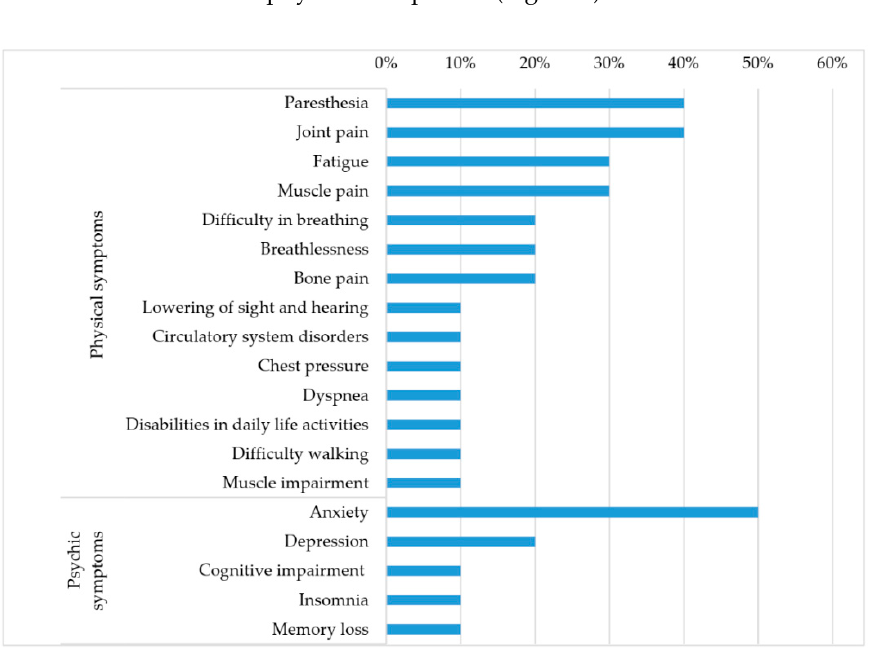
Figure 1. Long COVID symptoms: consequences of the disease on physical and mental health.